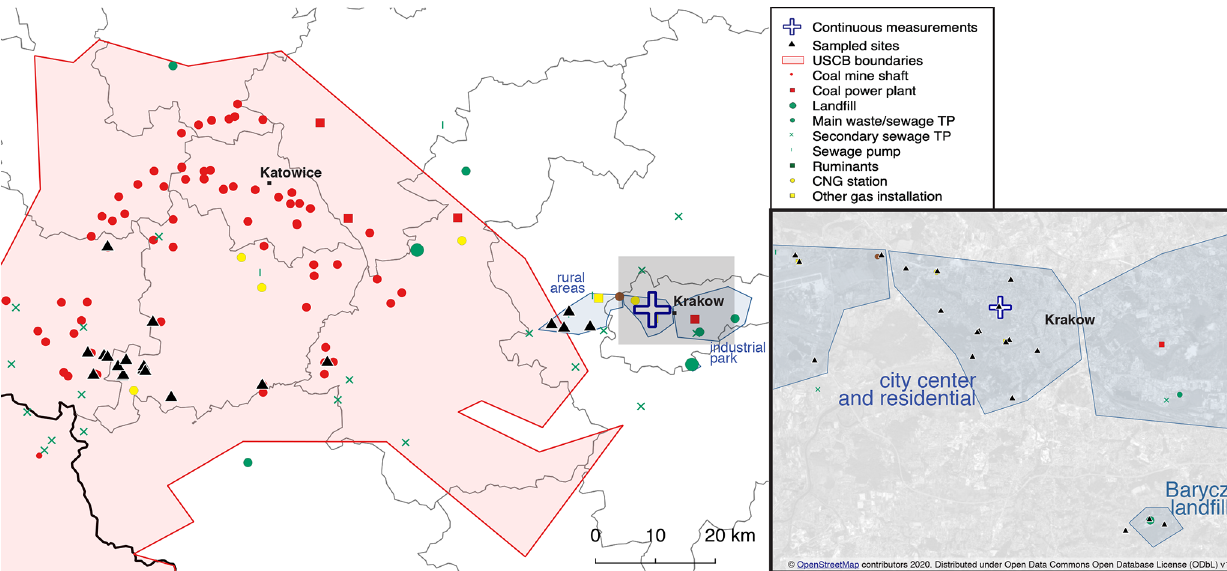
Figure 1. Location of the long-time measurements, sampled sites, and potential anthropogenic methane sources. Note that this is not an exhaustive list: not all the sewage pumps are reported, and no official information on cattle farms was obtained. Other emissions from mining activities, coming from processing facilities or waste disposal, are not reported here. No χ (CH 4 ) enhancements were measured around stagnant water bodies, therefore they are not all reported here (TP denotes the treatment plant, and CNG denotes the compressed natural gas). © OpenStreetMap contributors 2021. Distributed under the Open Data Commons Open Database License (ODbL)